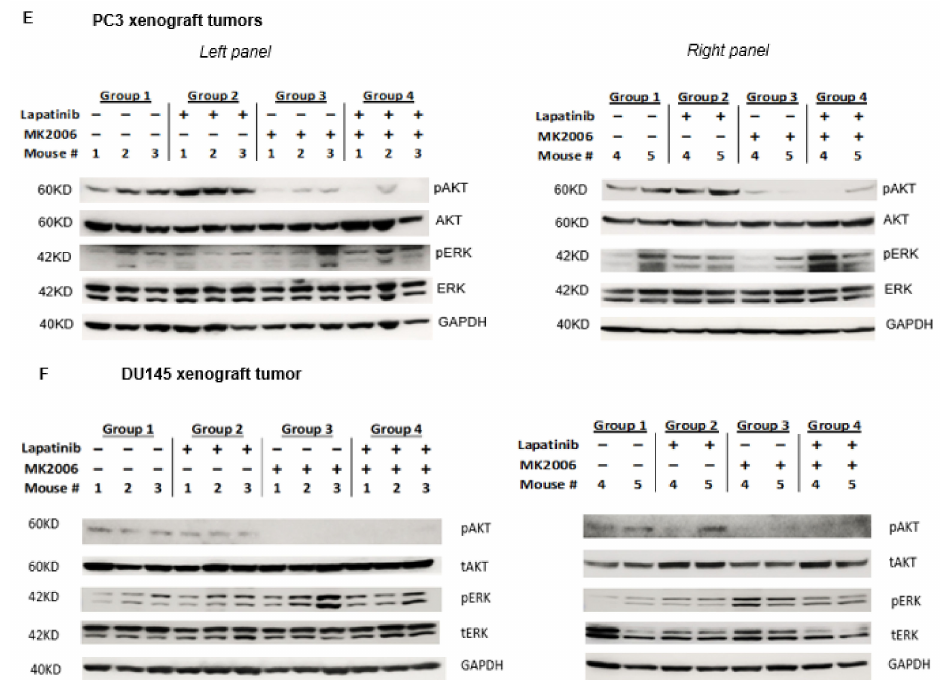
Figure 6. Targeting ErbB and AKT in vivo. Evaluation of PC3- and DU145-bearing tumor xenografts. ( A , B ) Tumor volumes of PC3 ( A ) and DU145 ( B ) tumors over time in response to the indicated treatments. Tumor volumes were assessed twice a week over the course of approximately 30